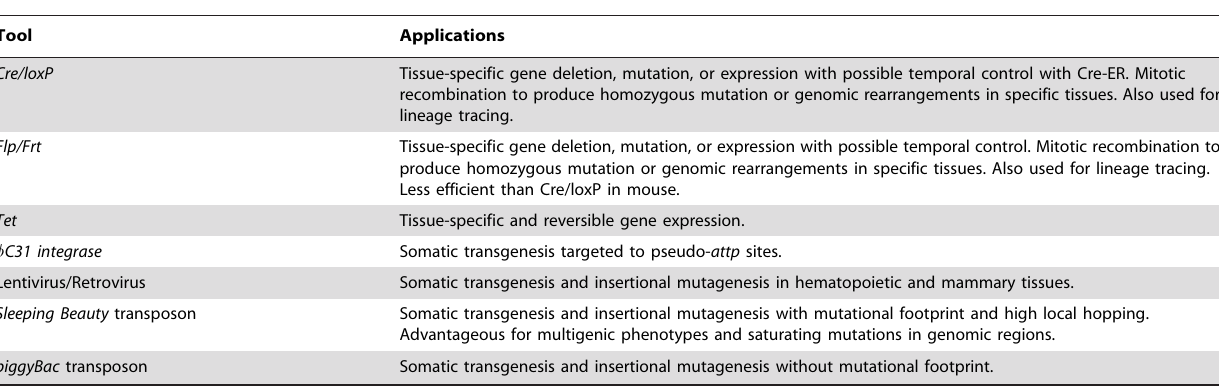
Table 1. Genetic Tools for Generating Mutant Clones and Somatic Mutagenesis in Mice.